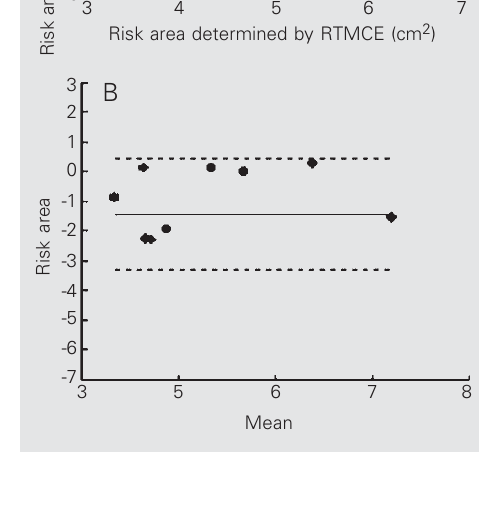
Figure 3. Correlation between risk areas determined by Evans blue staining and by real time myocardial contrast echocardi- ography (RTMCE) (A) and a Bland-Altman plot showing the mean difference (solid line) and limits of agreement (dashed lines) between measurements of risk area by the two methods (B).